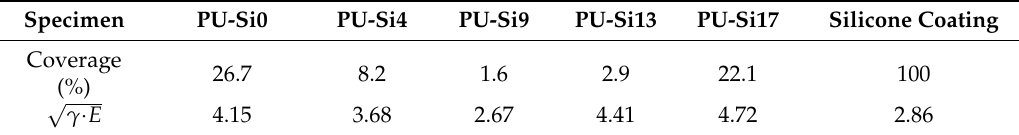
√ Table 4. The γ · E values and coverage of marine organism studied of the